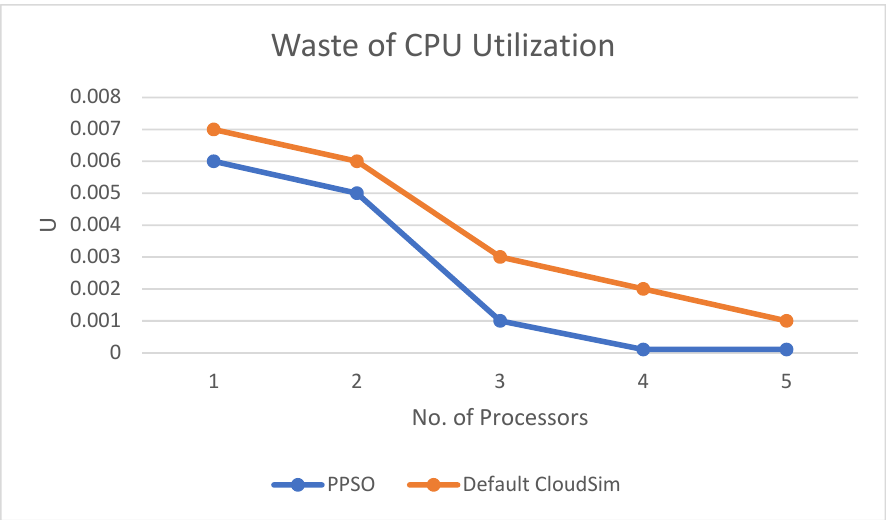
Figure 6. The relation between WT and number of processors.